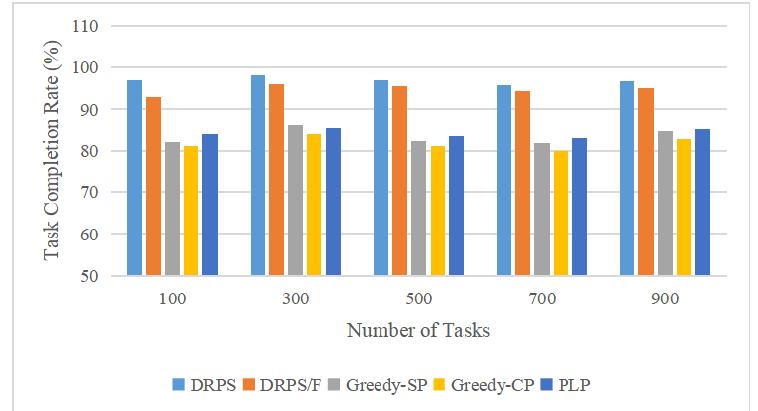
Figure 6. Results of the